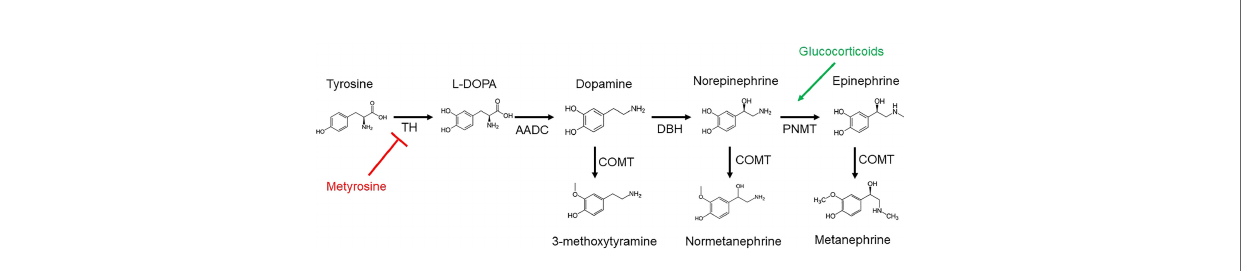
FIGURE 1 | Catecholamines and metanephrines are derived from tyrosine by the enzyme tyrosine hydroxylase (TH), resulting in L-3,4-dihydroxyphenylalanine (L-DOPA). Aromatic L-amino acid decarboxylase (AACD) generates dopamine from L-DOPA. Dopamine b -hydroxylase (DBH) acts on dopamine to produce norepinephrine, followed by the enzyme phenylethanolamine N -methyltransferase (PNMT) to yield epinephrine. Norepinephrine and epinephrine are O -methylated by catechol- O -methyltransferase (COMT) to produce normetanephrine and metanephrine, respectively. The corresponding O -methylated metabolite of dopamine is 3- methyoxytyramine (3-MT). Metyrosine inhibits (red) TH. Glucocorticoids stimulate (green) PNMT.